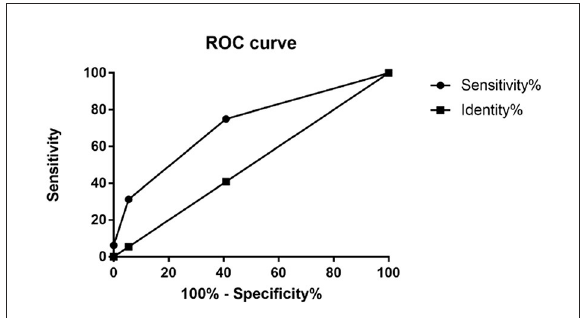
FIGURE2 Receiver operating characteristic (ROC) curves for the IPR score. The AUC value was 0.716 (95% CI: 0.58–0.86) for this model. AUC, area under the curve; CI, confidence interval. IPR, intraprocedural rupture.